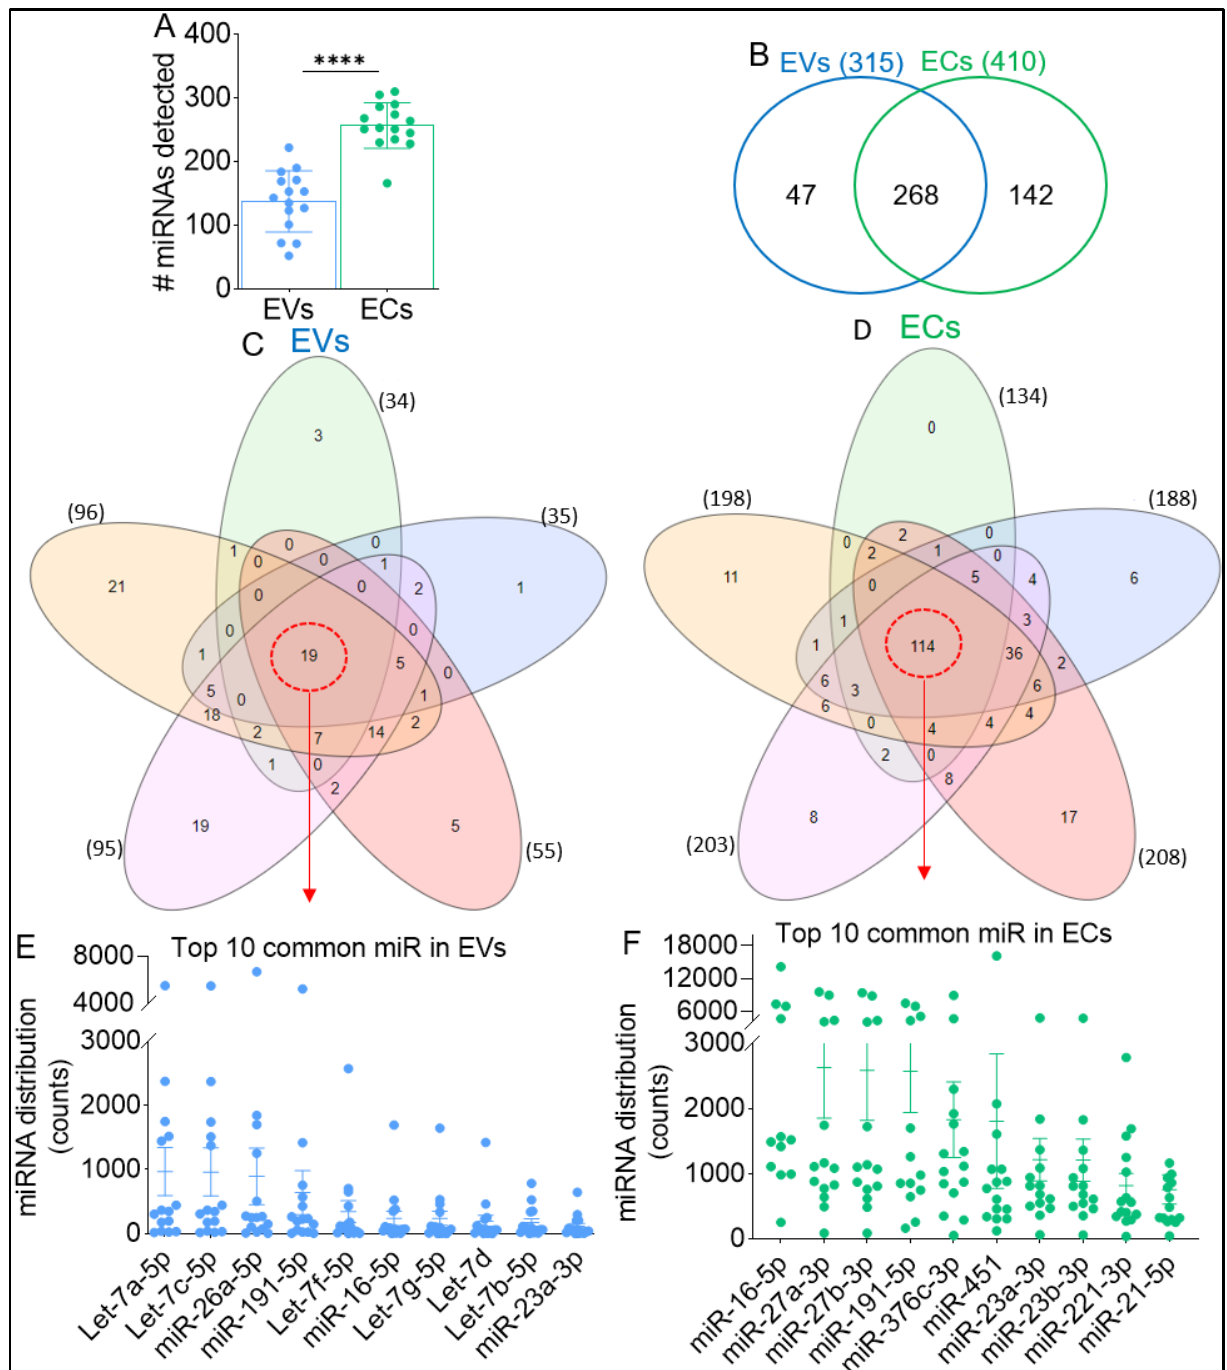
Figure 2. Identification of common BEV and BEC miRNAs. ( A ) Number of miRNAs detected (miRNA distribution count ≥ 1) for each RM ( n = 15), for both EVs and ECs. ( B ) Venn diagram comparing total detectable miRNAs for EVs and ECs ( n = 15). To be included in the list, miRNA count needed to be ≥ 1 at least 1 RM. ( C , D ) Venn diagram showing common and unique miRNAs among the 5 groups for ( C ) EVs and ( D ) ECs. Dotted red circle indicates miRNAs detected in monkeys ( n = 15) for EVs (19) and ECs (114). ( E , F ) Top 10 detected commonly expressed miRNAs as measured by miRNA distribution counts for ( E ) EVs and ( F ) ECs. Unpaired T‑test with Welch’s correction was used to assess statistical differences between EVs and ECs in panel ( A ). Error bars represent S.E.M. ****, p <0.0001. Table 2. Top 10 most highly enriched miRNA by counts in EVs and ECs from pre-infection plasma samples. Let-7 miRNA ID